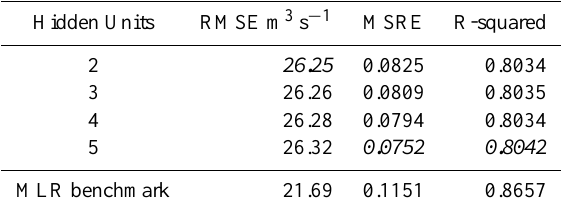
Table 4. Validation performance of candidate models for Scenario A. Best performing ANN models for each metric are in